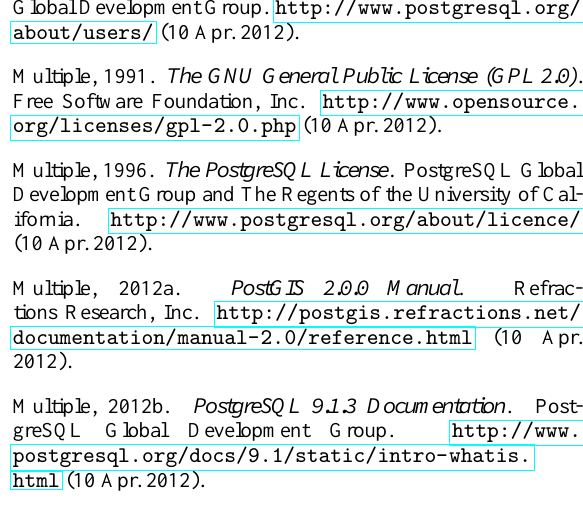
followed by and Opening using radius 0.00001 [1]. The